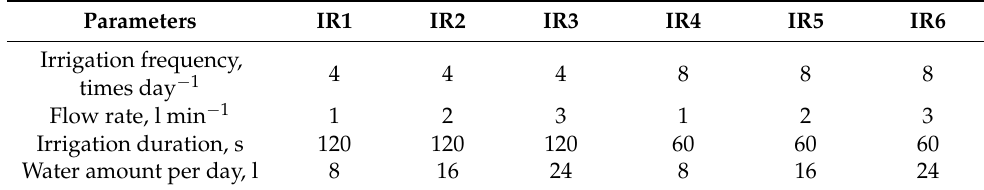
Table 1. Different irrigation scenarios and their parameters.